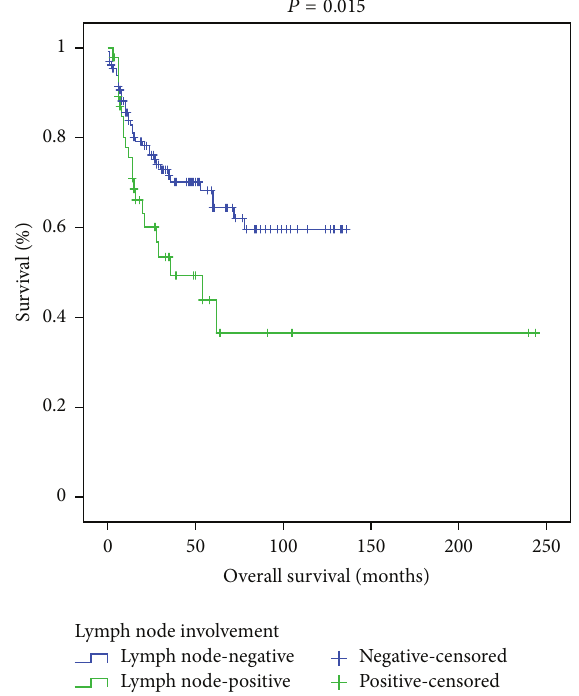
Figure 1: The Kaplan-Meier curves according to lymph node involvement ( 𝑃 = 0.015 ).